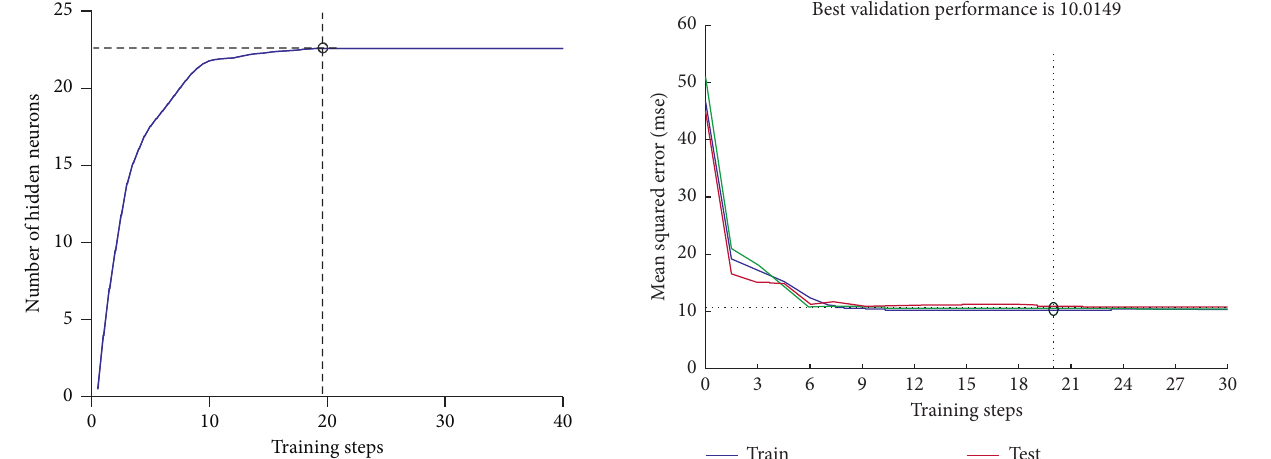
Figure 10: The variation curve of the number of hidden